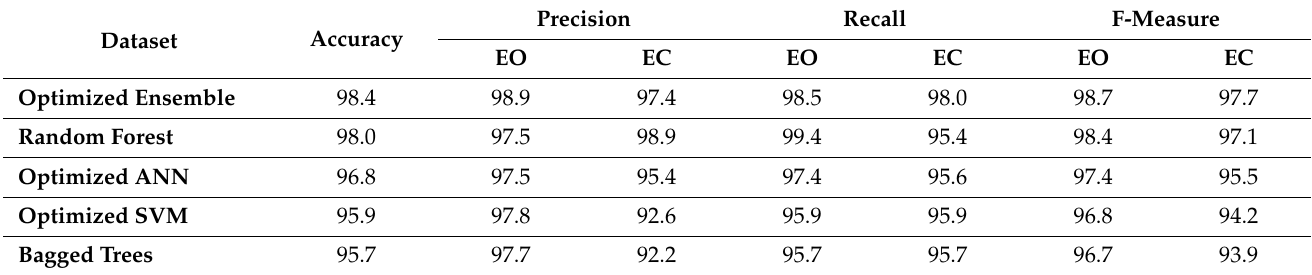
Table A2. The performance of the classifiers on Dataset SP10